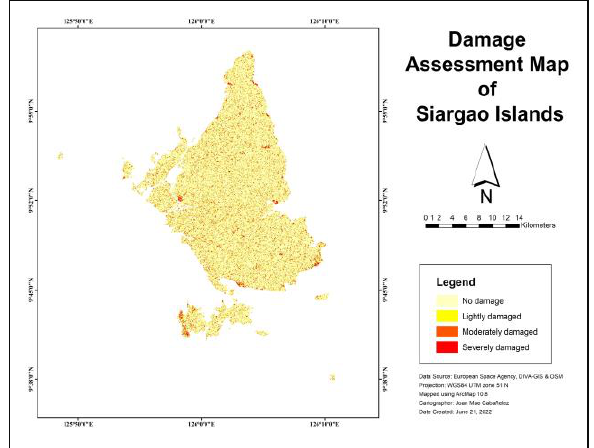
Figure 21 . Coherence-based derived damage assessment map for Siargao Islands using Sentinel-1 SAR